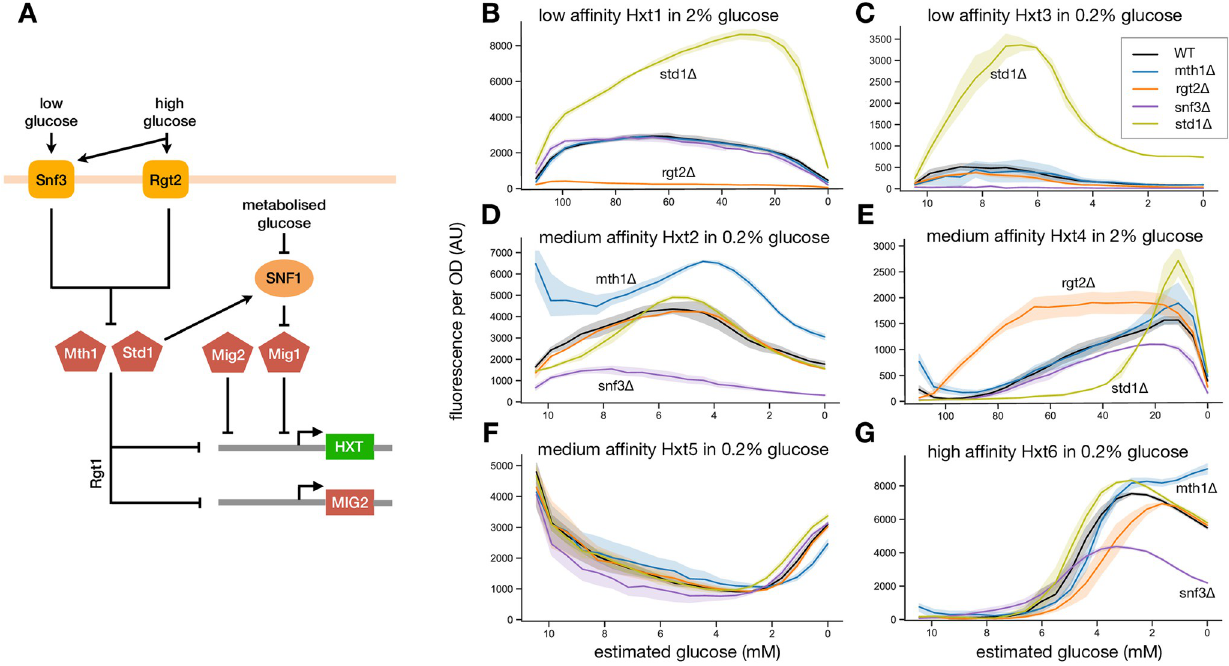
Fig 2. Measuring over time GFP-tagged outputs of a system of interest both in wild-type and in mutant strains missing components of the regulatory network can reveal much of the network’s structure. We illustrate with the network that controls the expression of hexose transporters in budding yeast. A Expression of the HXT genes is controlled by at least two subsystems, which together regulate the activities of four repressors. Extracellular glucose is sensed by the Snf3-Rgt2 network: Snf3 is a low affinity sensor; Rgt2 has a high affinity. Mth1 and Std1 are co-repressors that interact with the transcription factor Rgt1 to repress the HXTs. Extracellular glucose is sensed by the Snf3-Rgt2 system, which inactivates Mth1 and Std1 and increases HXT expression. Via Rgt1, the system also regulates MIG2, which encodes another repressor. Intracellular glucose is sensed by the SNF1 kinase complex, which when active phosphorylates a final repressor, Mig1. When phosphorylated, Mig1 exits the nucleus and cannot repress the HXTs. B-G Using plate readers we followed levels of Hxts tagged with GFP. We transformed the resulting time-series measurements first into GFP per cell and then, approximately, into functions of extracellular glucose by estimating glucose from the culture’s OD. Time increases from left to right as glucose falls and the OD increases. At the extreme left—corresponding to t = 0, the level of each Hxt is the level attained in the pyruvate used for pre-growth. Data are the average of at least two experiments, each with four biological replicates. Errors are 95% confidence intervals. B HXT1 is strongly repressed by Std1, and Rgt2 is required to relieve Std1’s repression. C HXT3 behaves similarly to HXT1, but expresses in low glucose and requires Snf3 to do so. D HXT2 is strongly repressed by Mth1 but not Std1, and Snf3 is required to relieve Mth1’s repression. E HXT4 is repressed by Mig1 and Mig2 in high glucose because its levels both decrease when STD1 is deleted and increase when RGT2 is deleted. F HXT5 is at best weakly regulated by the network—all mutants behave similarly to the wild-type strain. G HXT6 is strongly repressed by Mth1 but not Std1 in low glucose. HXT7, which also encodes a high affinity transporter, behaves similarly (Fig G in S1